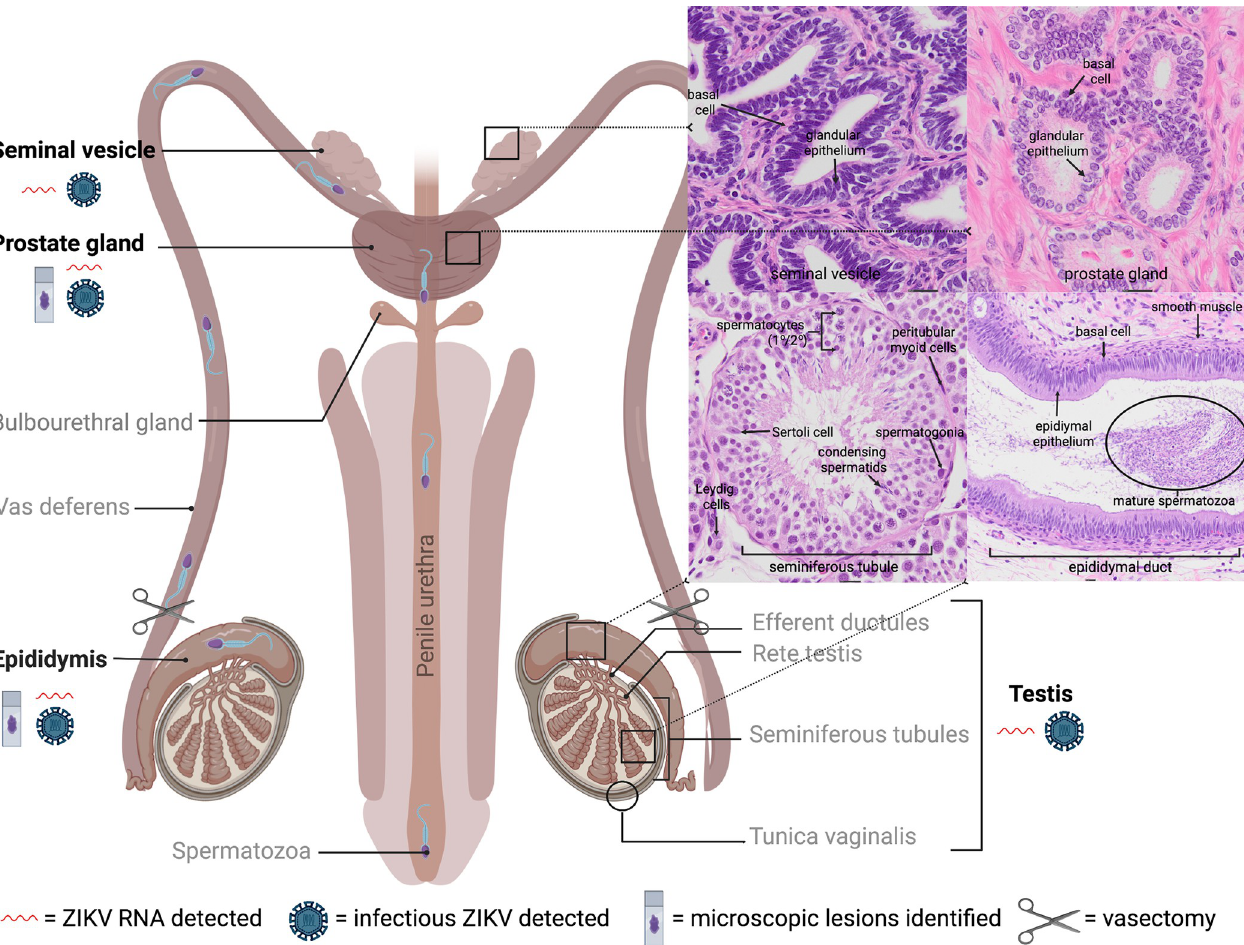
Fig 7. Normal anatomy and histology of the sexually mature male primate reproductive tract with summary of results. Tissues that were sampled are in bold. Insets (denoted by black boxes on diagram) depict normal microscopic features of each tissue. Mature spermatozoa develop in stages from germ cells (spermatogonia) in testicular seminiferous tubules (supported by Sertoli cells), undergo maturation and storage in the ducts of the epididymis, and travel via the vas deferens through the accessory sex glands and into the urethra for ejaculation [73, 74]. Both ZIKV RNA and infectious virus were detected in the testis, epididymis, seminal vesicle, and prostate gland. Microscopic lesions were noted in the sexually mature epididymis and prostate gland. Created with BioRender. com.